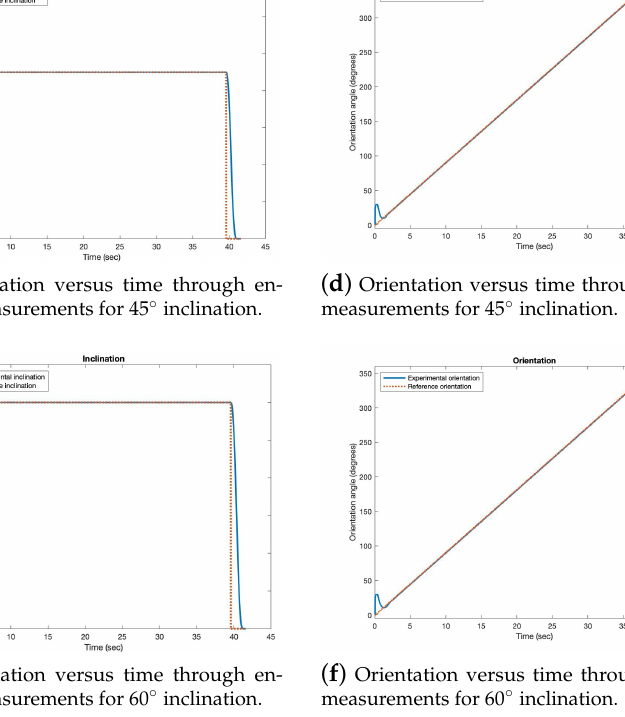
Figure 20. Test 2—Encoder data. Fixed 30 ◦ , 45 ◦ and 60 ◦ inclination for a 360 ◦ rotation. The blue